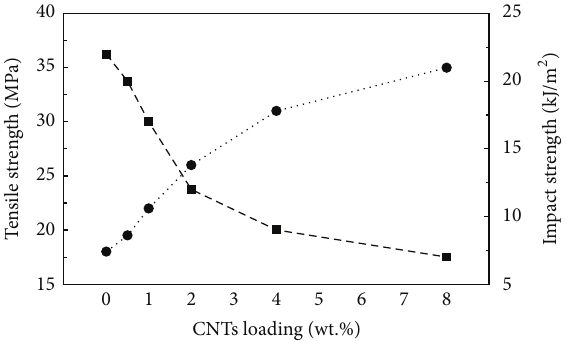
Figure 6: Tensile strength and impact strength of nanocomposites acquired, respectively, from static stress-strain and Izod pendulum impact testing data.